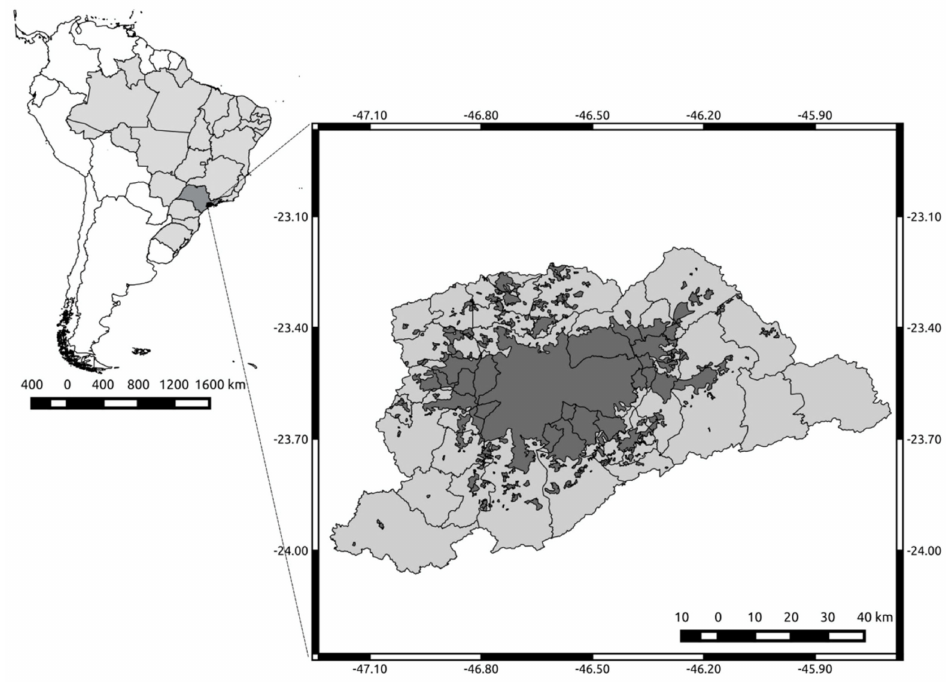
Figure 1. Location of the Metropolitan Area of S ã o Paulo (MASP) in Brazil and its urban sprawl. The area of the MASP—7946 square kilometers—corresponds to less than one-thousandth of the Brazilian territory and just over 3% of the territory of S ã o Paulo. It has approxi- mately the same dimensions as some nations, such as Lebanon (10,452 km 2 ) and Jamaica (10,991 km 2 ), and is larger than those of countries such as Luxembourg (2586 km 2 ) [31]. The urbanized area comprises 2200 square kilometers. Between 1962 and 2002, the urban area increased from 874 km 2 to 2209 km 2 . The metropolis suffers from the negative effects of conurbation, which deprive cities of their physical limits—owing to the unchecked growth of the urban area of MASP towards neighboring cities—giving rise to a continuous urban sprawl